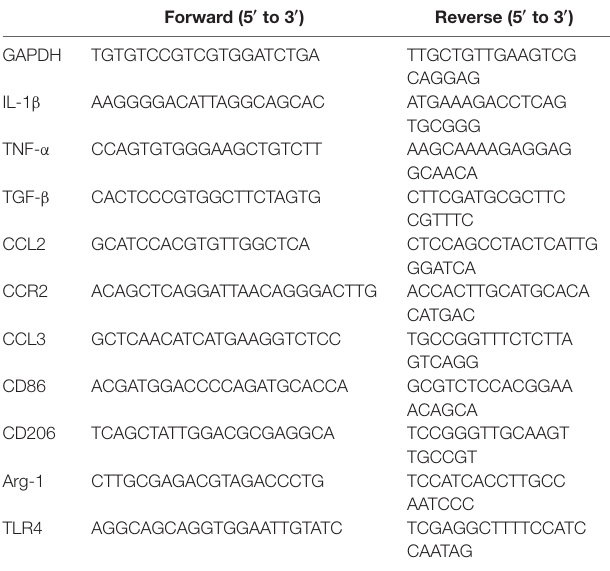
TABLE 1 | Primer sequences for real-time polymerase chain reaction (PCR). Forward (5 (cid:48) to 3 (cid:48) ) Reverse (5 (cid:48) to 3 (cid:48)